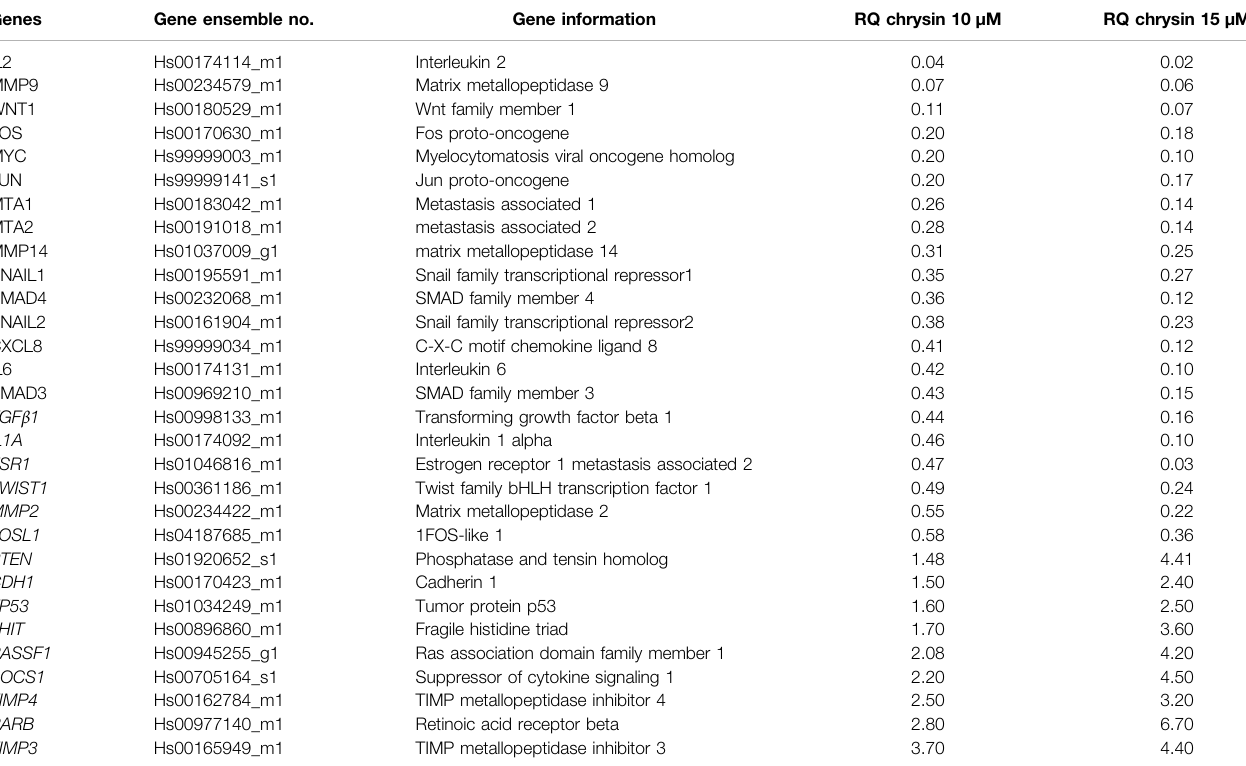
TABLE 1 | Relative expression of TSGs and genes related to migration and metastasis. The values are taken as mean of three experiments ± SD ( p ≤ 0.05). Genes Gene ensemble